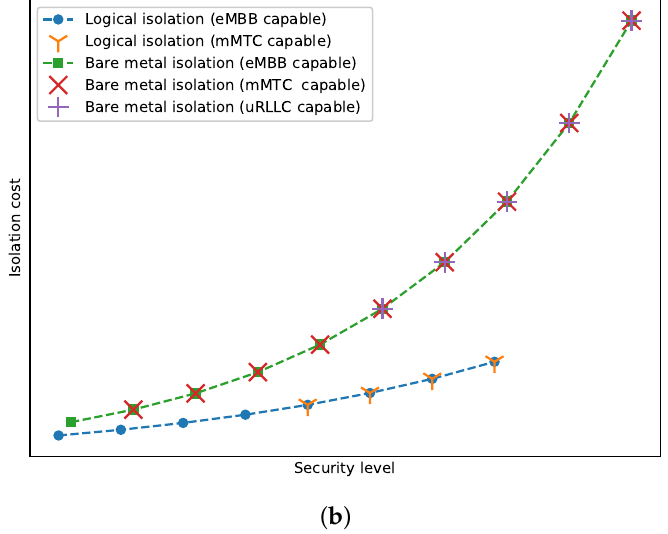
Figure 6. How to select the appropriate NS isolation plan: ( a ) check the QoS satisfaction under different isolation plans, and ( b ) select the isolation plan with regards to the trade-off between security and